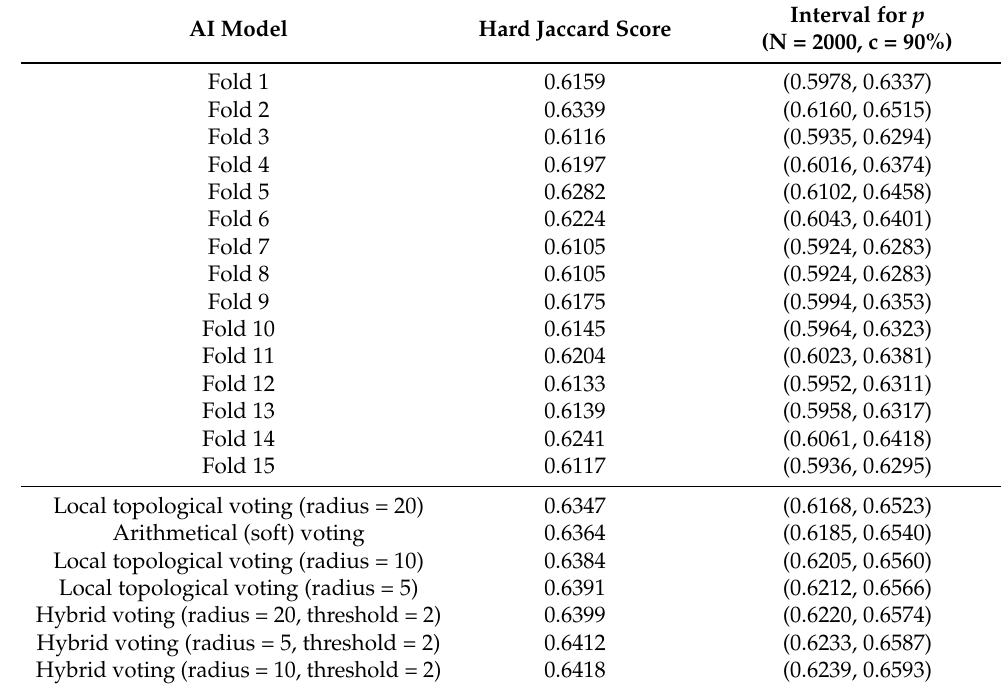
Table 5. Comparison of voting methods on 15 folds for the DRIVE